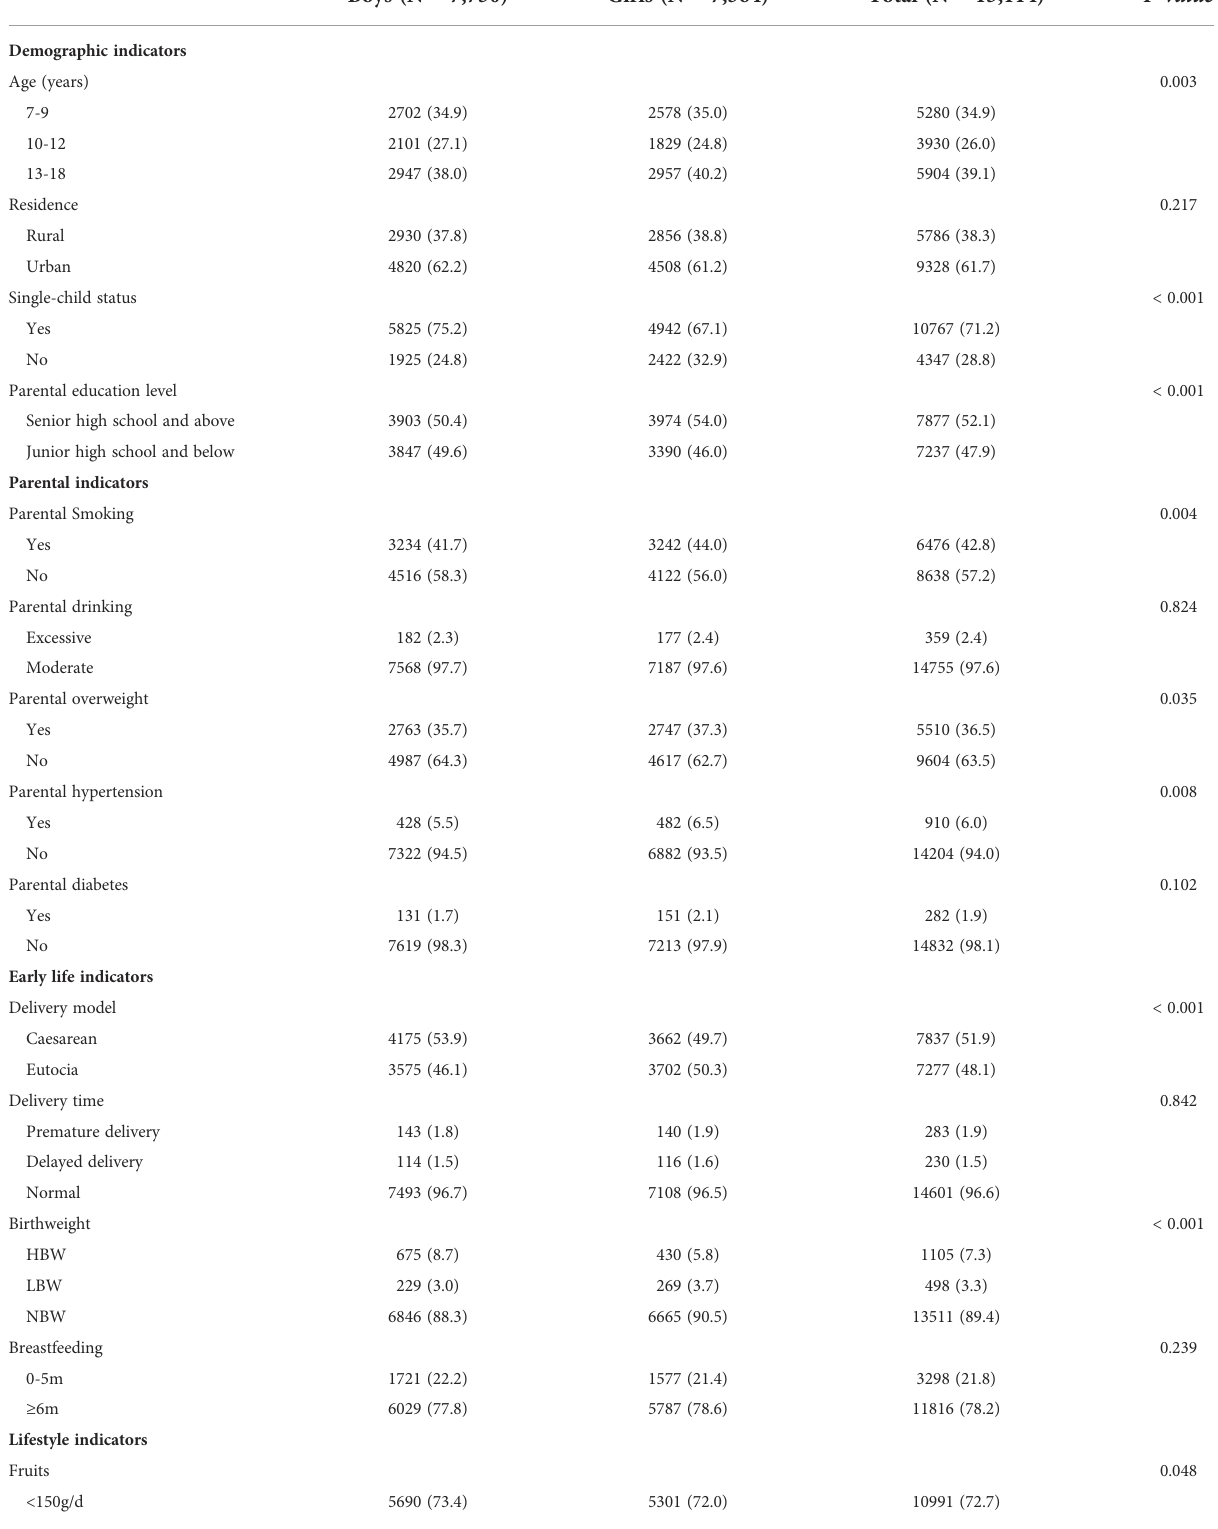
TABLE 1 Characteristics of the study